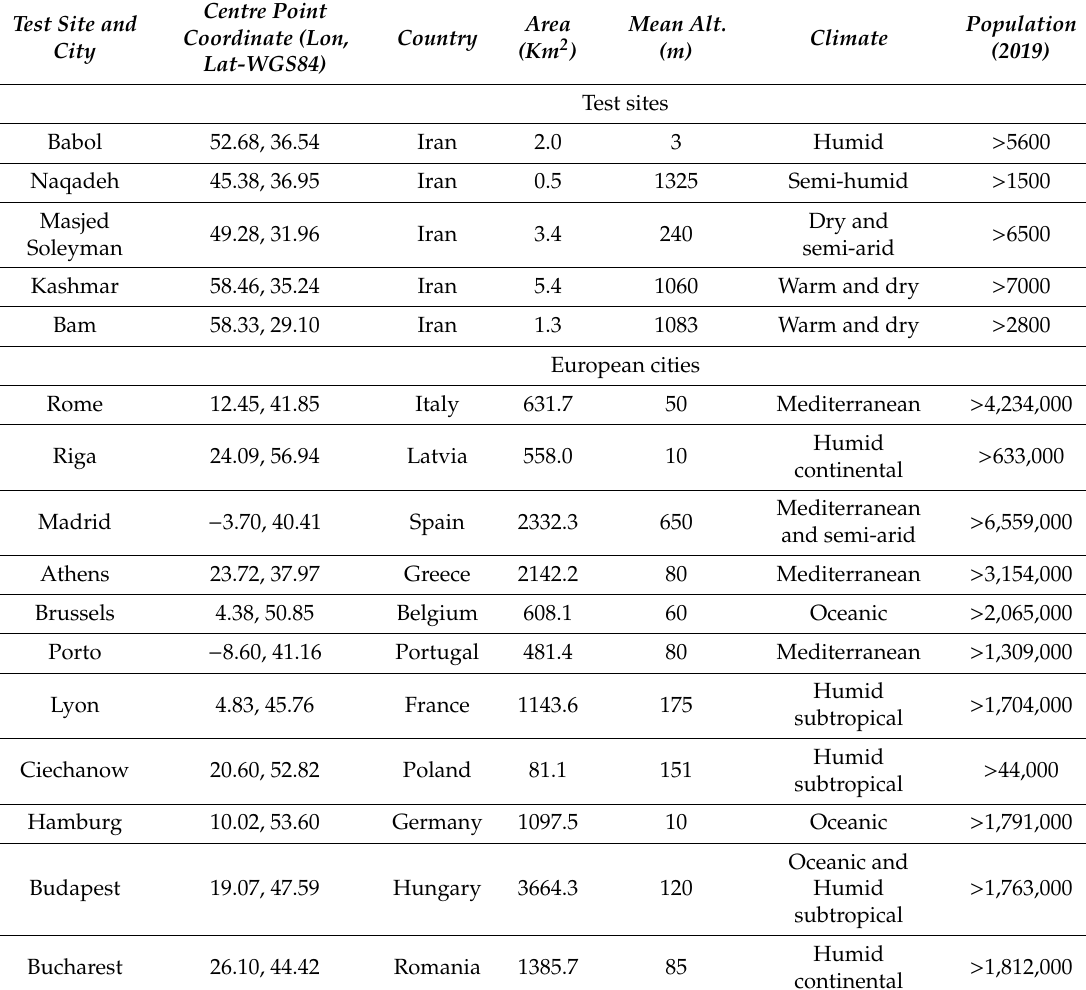
Table 1. General characteristics of the test sites and